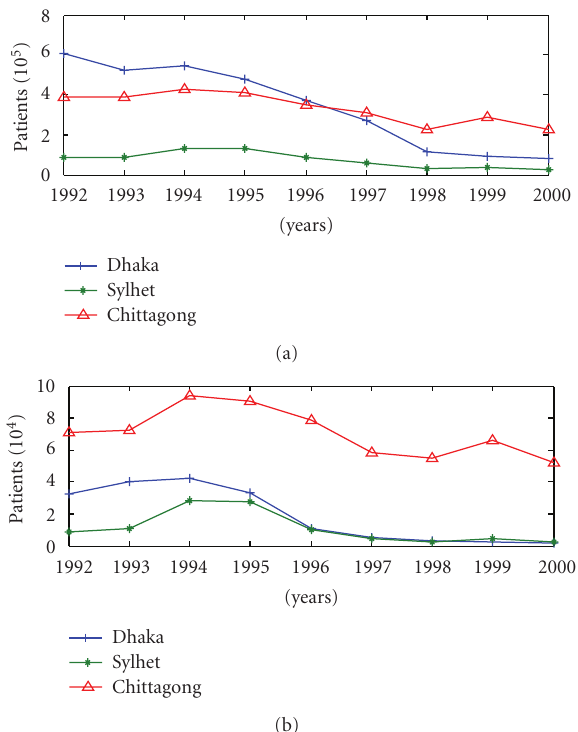
Figure 2: Yearly (a), the number of patients (patient’s total PT) whose blood sample was tested for malaria (b), the number of positive malaria cases